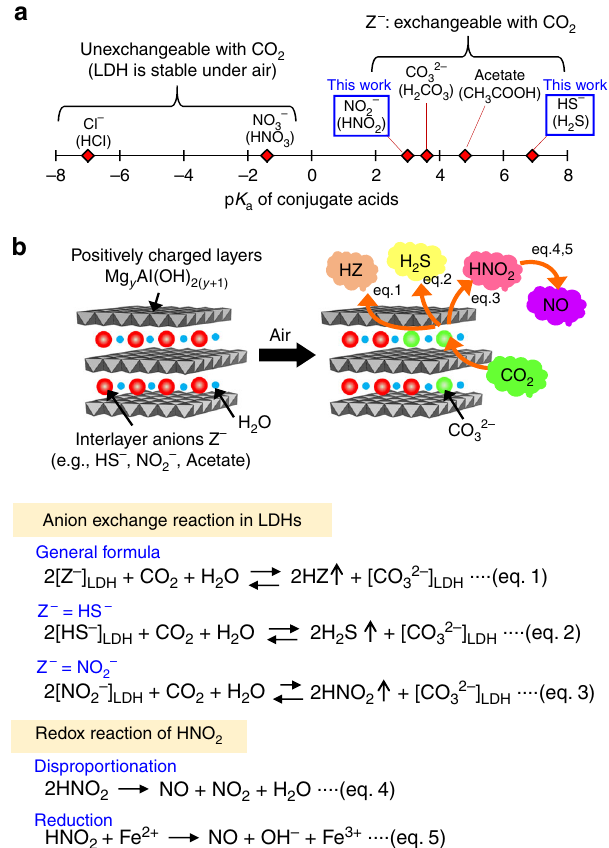
Fig. 1 Design of solid materials that release functional gases in response to CO 2 . a Susceptibility of interlayer anions (Cl − , NO 3 − , NO 2 − , CO 3 2 − , acetate, and HS − ) of LDHs for CO 2 -stimulated anion exchange, showing correlation with p K a values of the conjugate acids. Z − denotes a conjugate base of volatile weak acid. b Release of various gases (HZ, H 2 S, HNO 2 , or NO) from LDHs through anion exchange between interlayer anions (Z − , HS − , or NO 2 − ) and aerial CO 2 (eq. 1 – 3), disproportionation (eq. 4), and reduction (eq. 5). Note that interlayer- and aerial-H 2 O are available in eq. 1 –